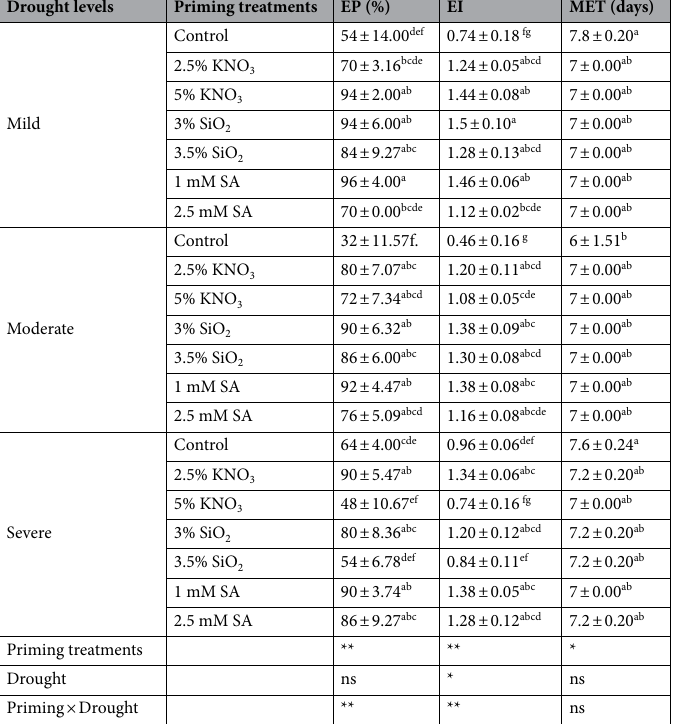
Table 1. Emergence attributes of KNO 3 , SiO 2 and SA primed rice under drought conditions. Mean values ± SE in the same column followed with similar letters are not significantly different according to DMRT ( P ≤ 0.05); SE Standard error of the mean, EP Emergence percentage, EI Emergence index, MET Mean emergence time, *Significant at 5% level of probability, **Significant at 1% level of probability, ns not